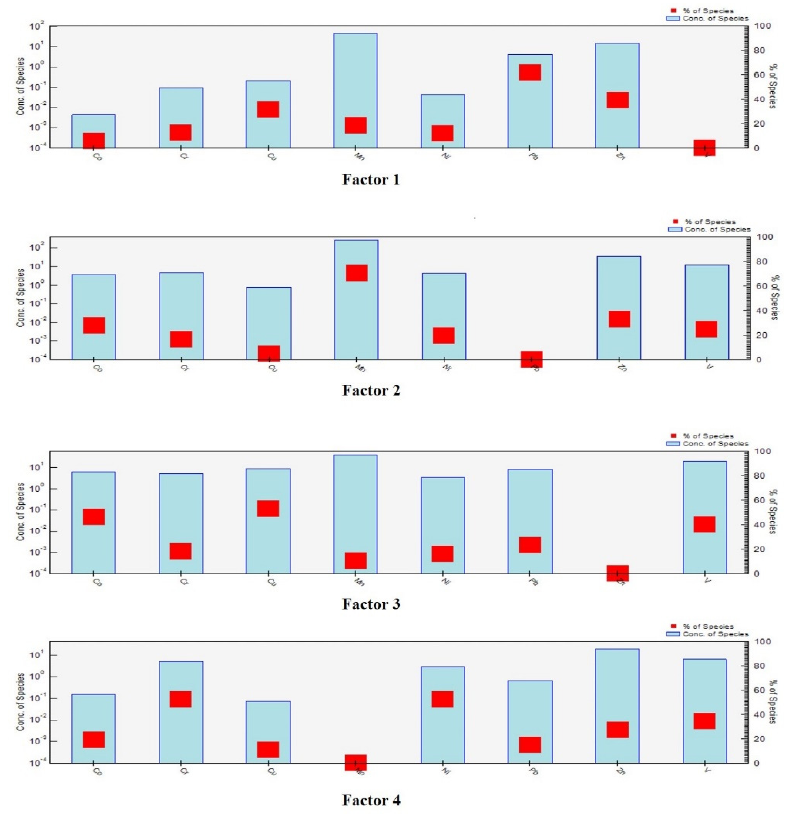
Figure 5. Factor profiles and origin contributions of potentially toxic elements in soil based on PMF.